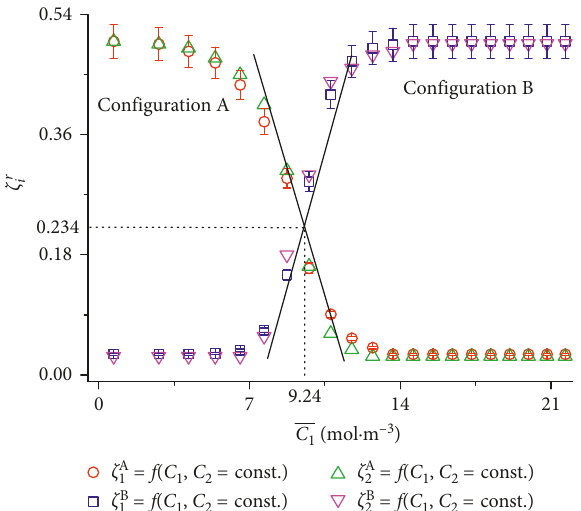
Figure 2: Dependencies of concentration polarization coefficient 1, 2) on glucose concentration in 201mol m ( ζ r k , k (cid:31) ethanol solution for configuration A ( r single-membrane system [31, 32].